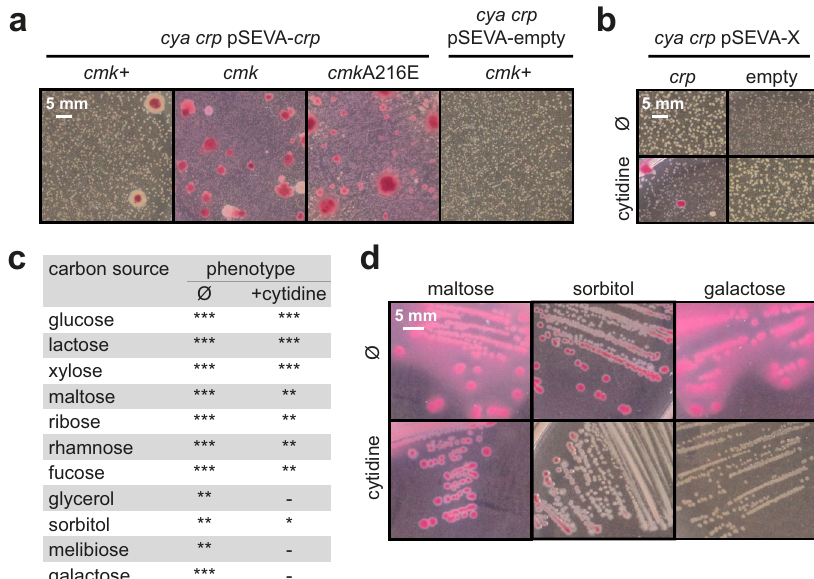
Fig. 3 In fl uence of cytidine and cmk mutations on the phenotypes of E. coli on MacConkey agar supplied with different carbon sources. a Papillation assay of cya crp cmk + , cya crp cmk , and cya crp cmk A216E strains on maltose with crp supplied on a low-copy plasmid or the empty plasmid as control. Pictures were taken after 7 days of incubation. b Papillation assay of the cya crp strain on maltose with or without crp supplied on a low-copy plasmid and with or without 10 mM cytidine. Pictures were taken after 3 days of incubation. c Phenotypes of the E. coli wildtype strain when supplemented with different carbon sources with or without 10 mM cytidine. Fermentation phenotypes are indicated by *** (red color and media acidi fi cation), ** (red color but no media acidi fi cation), * (limited red color), or - (white color). d Representative pictures of strains, where cytidine has an inhibiting effect on fermentation. Referenced phenotypes on all carbon sources can be found in Supplementary Fig. 4. Ø; no